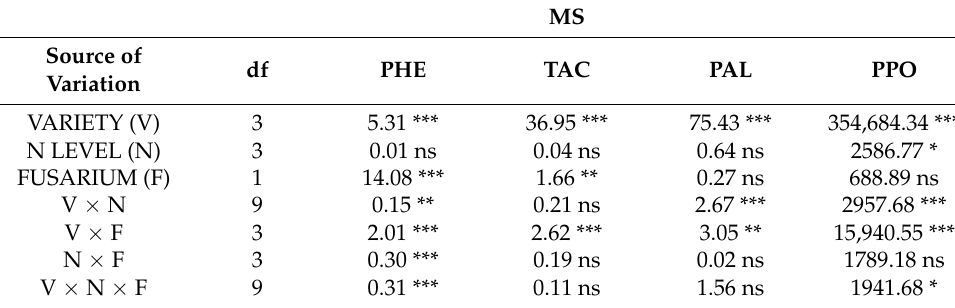
Table 3. Analysis of variance (three-way ANOVA) for measured biochemical parameters under different nitrogen and Fusarium treatments in spikes of four different winter wheat varieties in the 2018/2019 growing season.